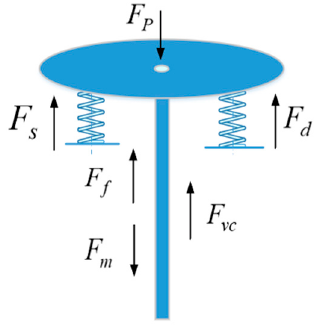
Figure 5. Stress analysis of valve stem.